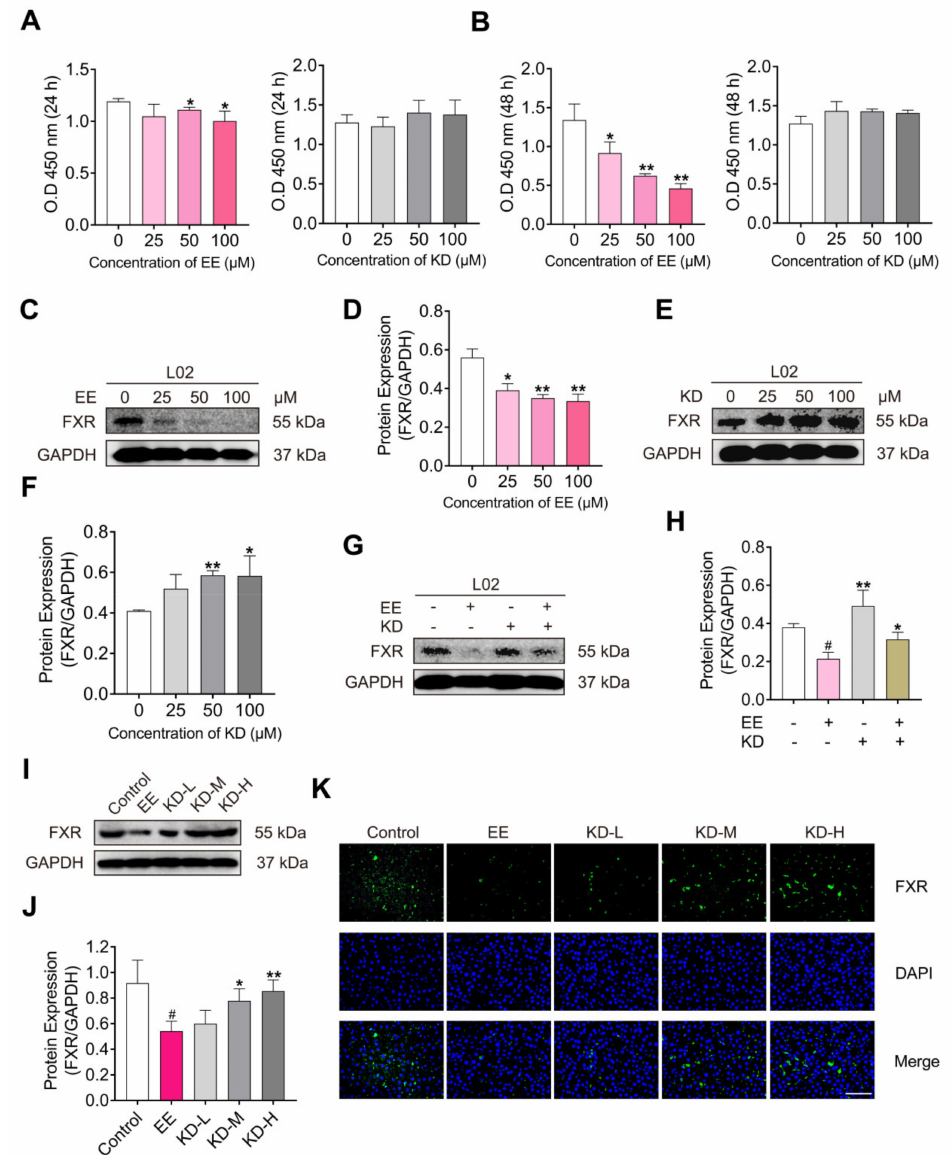
Figure 5. The effects of KD on the protein expression of FXR in human hepatocyte cell line L02 cells and rat liver with EE-induced cholestasis. ( A , B ) L02 cells were treated with EE or KD at different concentrations (0, 25, 50, 100 µ M) for 24 or 48 h. The values of O.D 450 nm were measured by CCK-8 assay to indicate cell viability. ( C ) The protein expression of FXR in L02 cells treated with EE (0, 25, 50, 100 µ M) for 48 h was detected using Western blotting. ( D ) The relative protein expression of FXR was analysed by using Image J software. ( E ) The protein expression of FXR in L02 cells treated with KD (0, 25, 50, 100 µ M) for 48 h was detected using Western blotting. ( F ) The relative protein expression of FXR was analysed by using Image J software. ( G ) The protein expression of FXR in L02 cells treated with EE (25 µ M, +), KD (25 µ M, +) or EE combined with KD for 48 h was detected using Western blotting. ( H ) The relative protein expression of FXR was analysed by using Image J software. ( I ) The protein expression of FXR in rat liver was detected using Western blotting. ( J ) The relative protein expression of FXR was analysed by using Image J software. ( K ) Immunofluorescence staining of FXR in the liver. Green color indicates FXR and blue color indicates cell nuclei. Scale bar, 100 µ m. Data are presented as mean ± SD ( n = 3). In ( A , B , D , F ), * p < 0.05 and ** p < 0.01 denote statistical significance, compared to the control group. In ( H , J ), # p < 0.05 denotes statistical significance, compared to the control group. * p < 0.05 and ** p < 0.01 denote statistical significance, compared to the EE